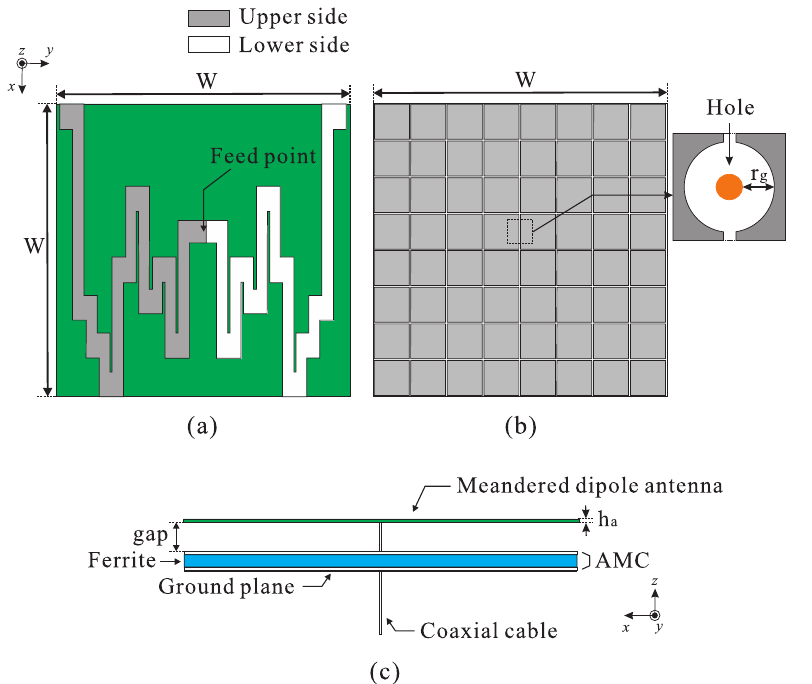
Figure 5. Geometry of the proposed antenna with the AMC: ( a ) meandered dipole antenna; ( b ) 8 × 8 AMC; ( c )